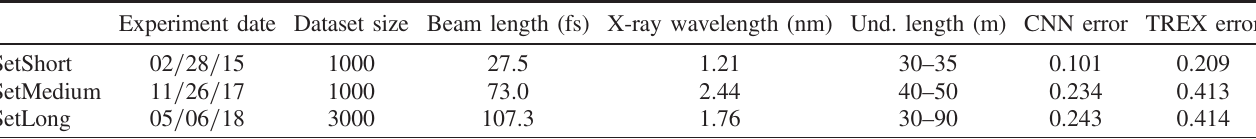
TABLE I. Beam parameters and training results for the three datasets. Undulator length (Und. length) randomly chosen within the range given. CNN and TREX Errors are averaged RRMSE on the 5% of the overall simulations reserved as a test